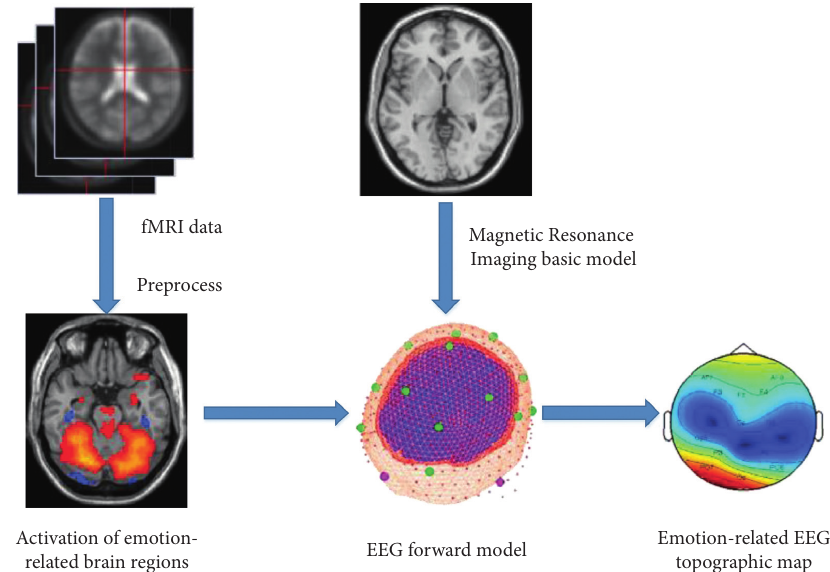
Figure 1: Specific process of generating emotion-related EEG topographic